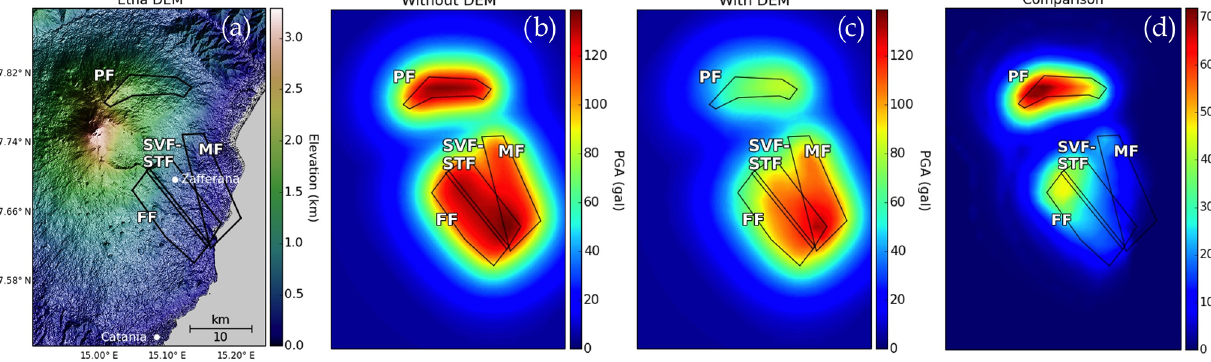
Figure 6. A hypothetical example showing the sensitivity of the hazard results to topography considering area sources and using the Open- Quake engine. The source geometries have assigned the same FMD and a depth of 2.5km. (a) Etna DEM, (b) hazard without DEM (sites at sea level), (c) hazard with DEM (sites on topographic surface) and (d) residuals (given by b minus c